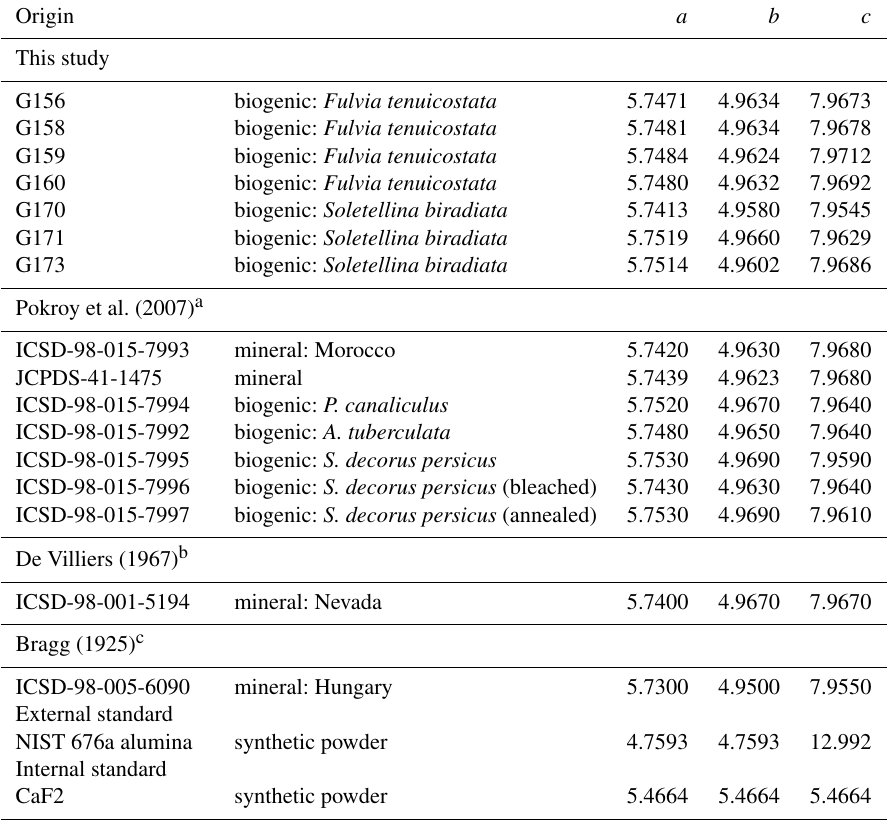
Table 1. The lattice parameters a , b and c (Å) of aragonite after Rietveld refinement and other reference materials for comparison. Perna canaliculus : marine bivalve, Acanthocardia tuberculata : marine bivalve and Strombus decorus persicus: marine